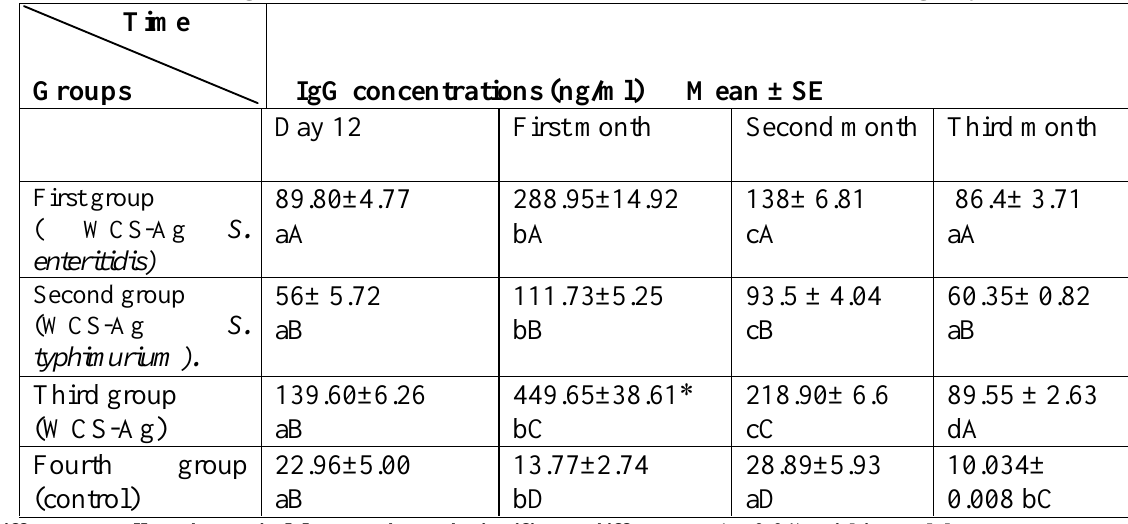
Table -2: Means of IgG concentration of immunized rabbits with WCS Ags by